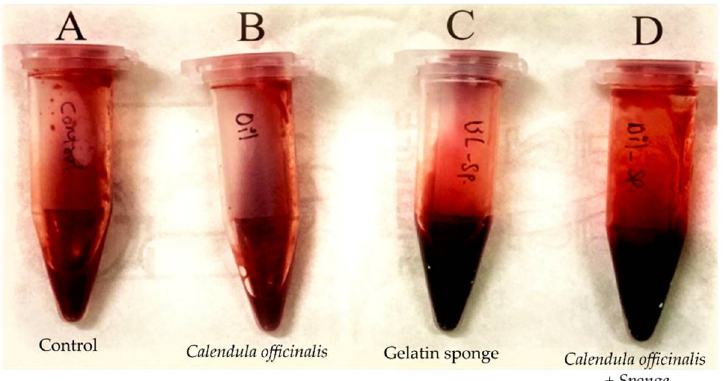
Figure 10. Blood clot formation using Lee–White method. Control tube ( A ) showing Blood clot formed that does not contain any agents, tube ( B ) with blood clot containing Calendula officinalis oil, tube ( C ) contains gelatin sponge, and tube ( D ) containing the test agent 7% Calendula officinalis oil incorporated in gelatin sponge.